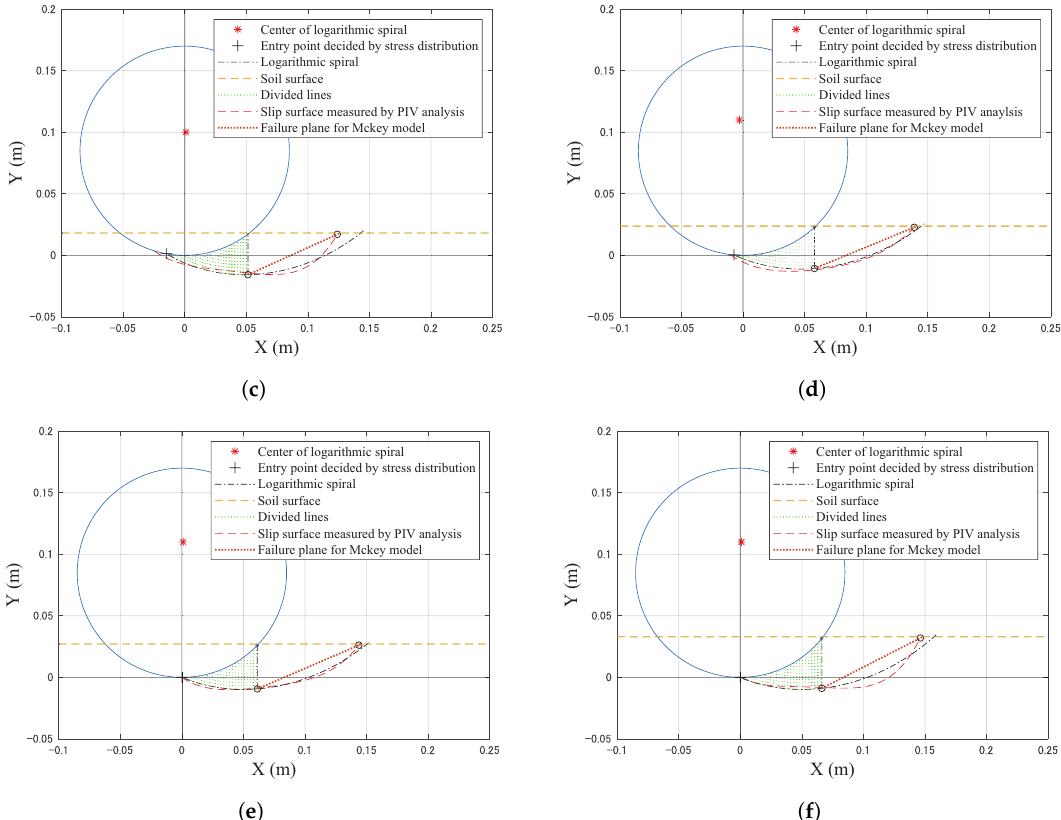
Figure 19. Schematic view of the preliminary model for calculating resistance force. ( a ) Sinkage: 0.013 (m), ( b ) sinkage: 0.015 (m), ( c ) sinkage: 0.018 (m), ( d ) sinkage: 0.023 (m), ( e ) sinkage: 0.028 (m), ( f ) sinkage: 0.033 (m).